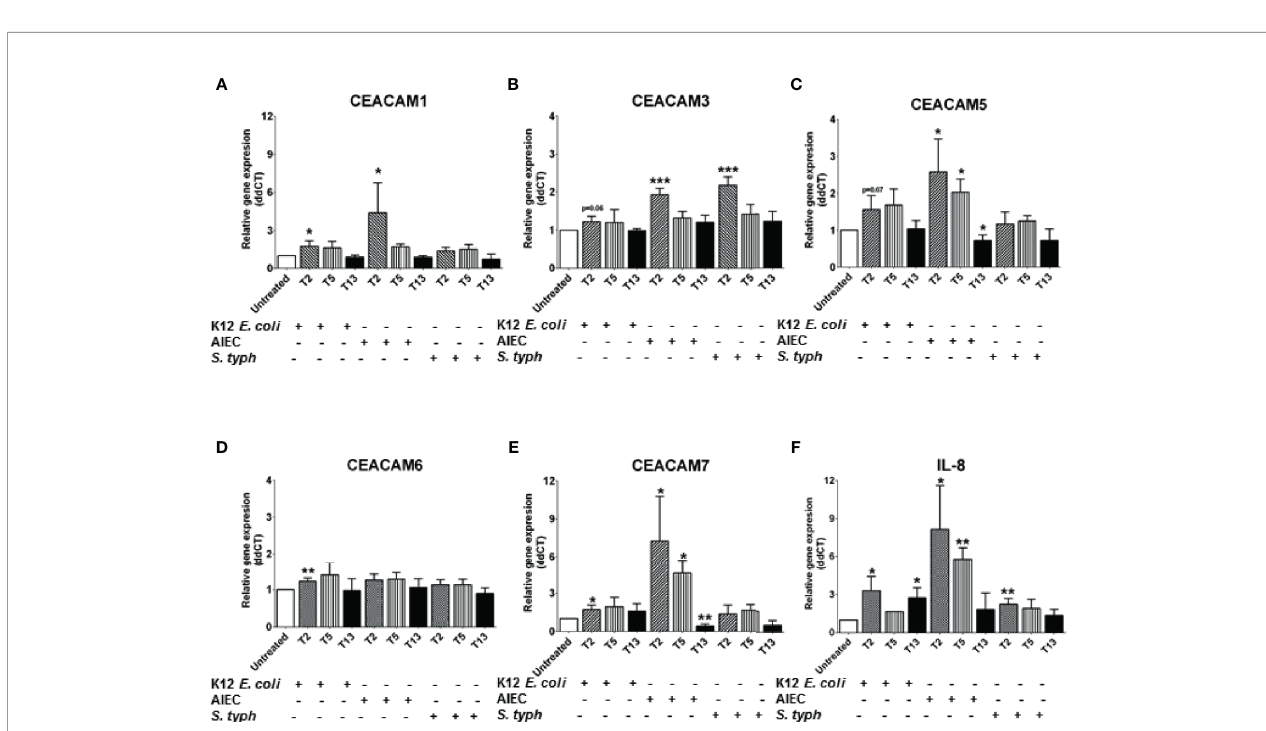
FIGURE 4 | Relative gene expression pro fi le in C2BBe1 cells co-cultured for 3 h with whole bacteria — Escherichia coli K12 (K12 E. coli ), Adhesion and Invasive E. coli (AIEC)-HM605, Salmonella typhimurium ( S. typh ) at a MOI 10:1 and untreated. After the 3 h co-culture, cells are washed in medium containing antibiotics followed by further culture in full culture media for 2 (T2), 5 (T5), and 13 (T13) h. Samples are collected at each time point for analysis on gene expression of (A) CEACAM1, (B) CEACAM3, (C) CEACAM5, (D) CEACAM6, (E) CEACAM7, (F) IL-8 as determined by RT q-PCR. Graphs are representative of two to four independent experiments with pooled triplicate samples and qRT-PCR assay performed in duplicates. b -actin was used as a housekeeping gene, and results are expressed as fold change. A Student t-test was used to analyze gene expression data. *P < 0.05, **P < 0.01, ***P < 0.001 when compared to untreated